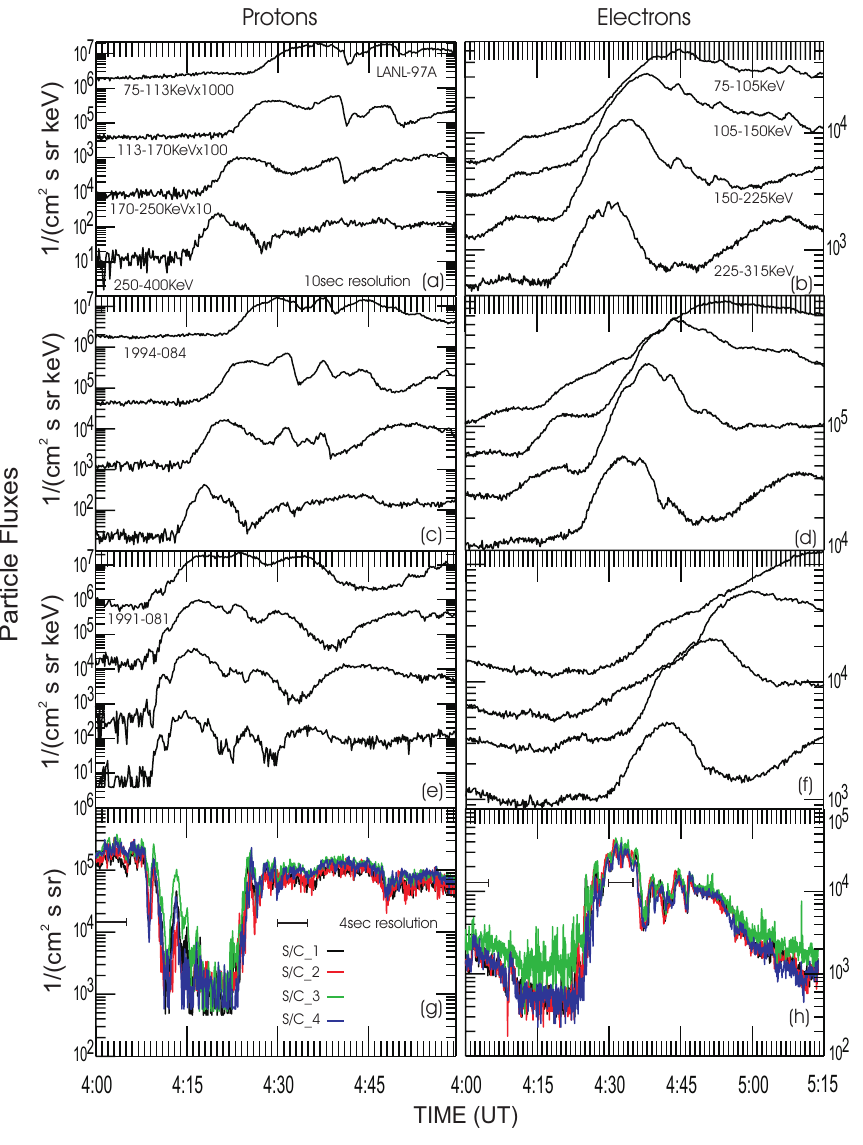
Fig. 3. An overview of proton and electron flux measurements obtained from geosynchronous and Cluster spacecraft between 04:00– 05:00 UT and 04:00–05:15 UT, respectively, on 27 August 2001. Also, the horizontal bars denote the time intervals for which the proton and electron energy spectra have been calculated (see Fig.